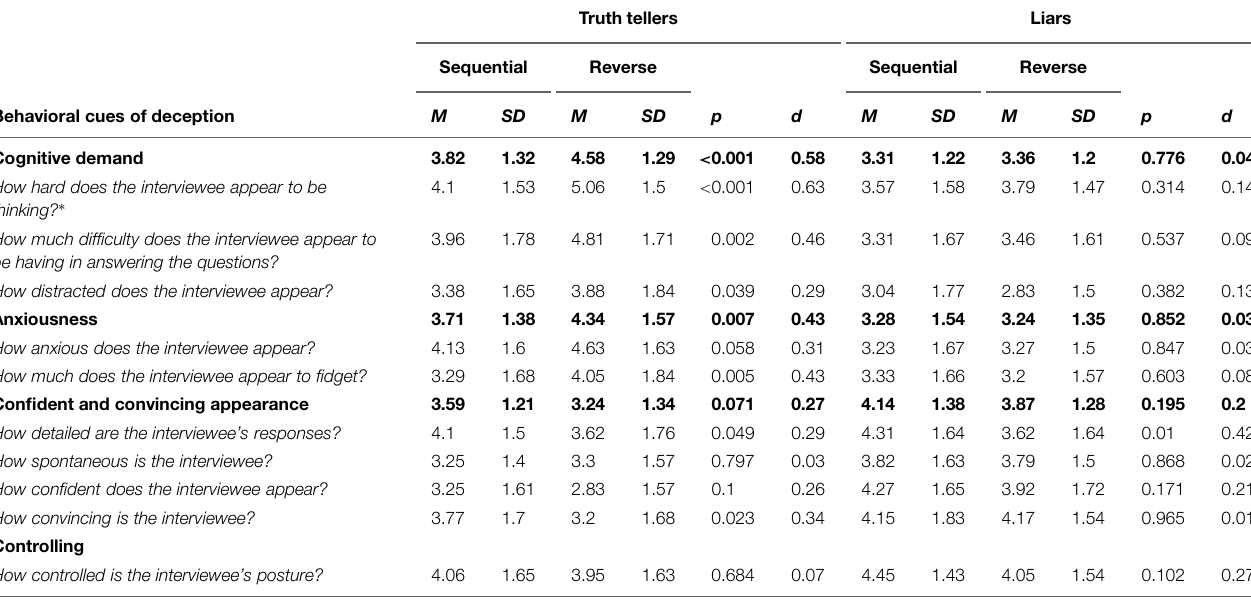
TABLE 3 | Ratings for behavioral cues to deception as a function of interview type and veracity. Truth tellers Liars Sequential Reverse Sequential